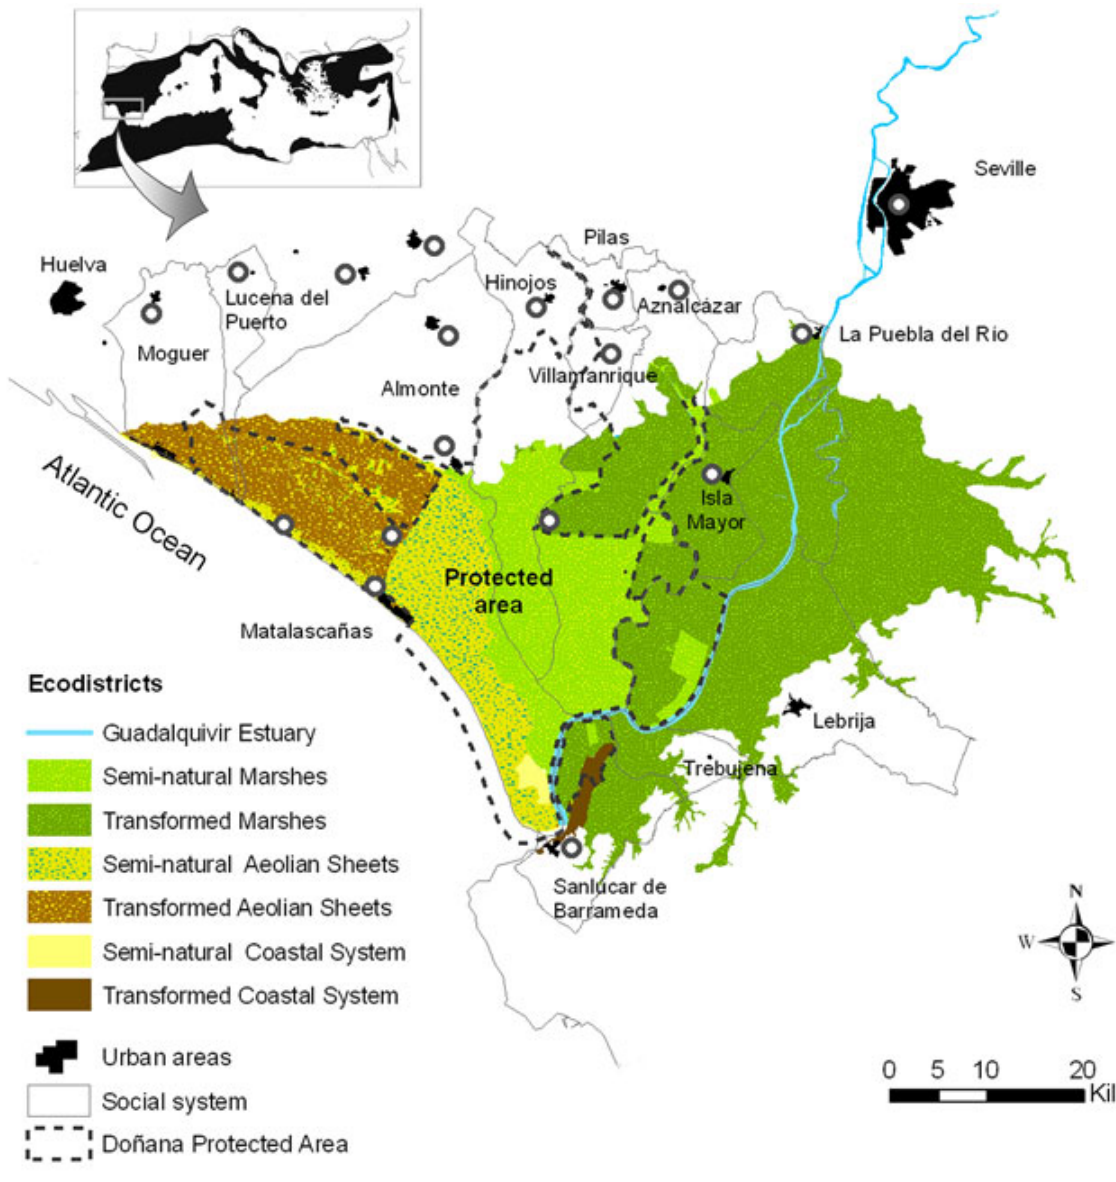
Fig. 1 . The Doñana social-ecological system, and the ecodistricts that constitute the Greater Fluvial- Littoral Ecosystem of Doñana. The semi-natural ecodistricts are those ecosystems modified by human use throughout history in a process of co-evolution. Transformed ecodistricts are those that have suffered a great modification (degradation) in the second half of the 20th century, mainly due to the introduction of agriculture, forest plantations, or aquiculture. Sample points are those places where interviews and questionnaires were made. The main use in the white areas is